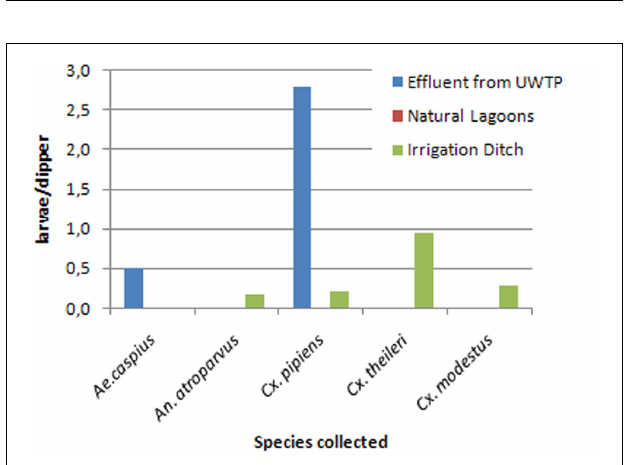
FIGURE 7 | Culicid immature species, and relative density, according to the nature of the biotope, in the surveyed lagoons.